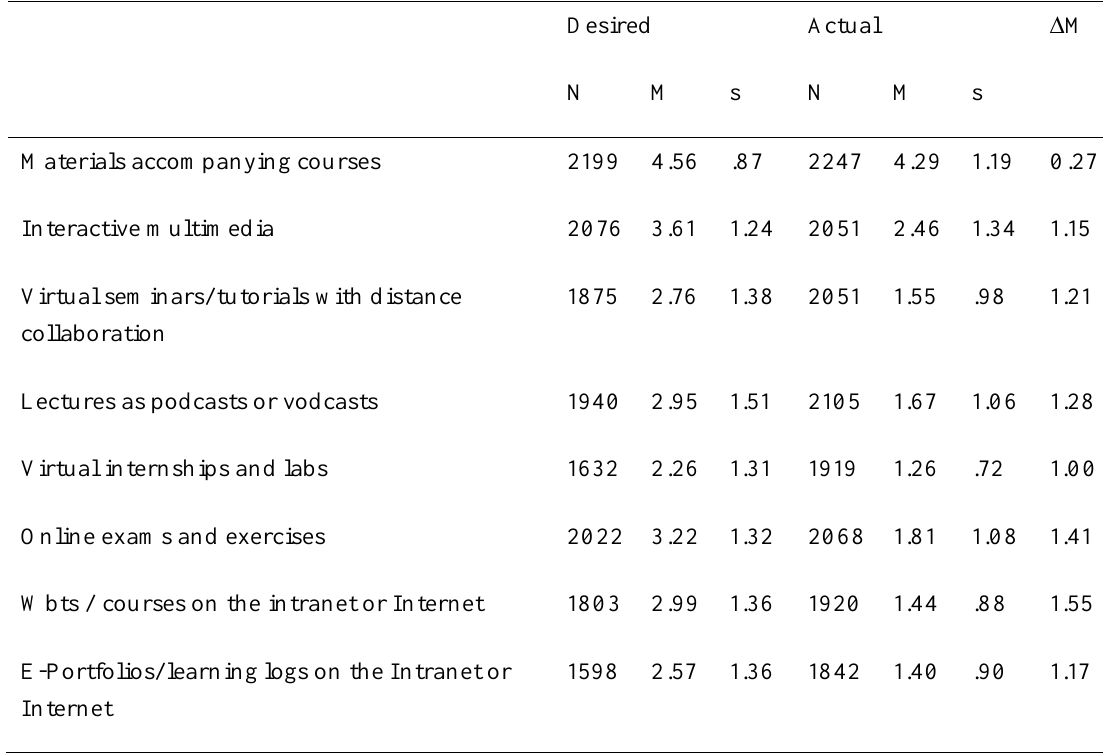
Demand For Digital Teaching and Learning Approaches